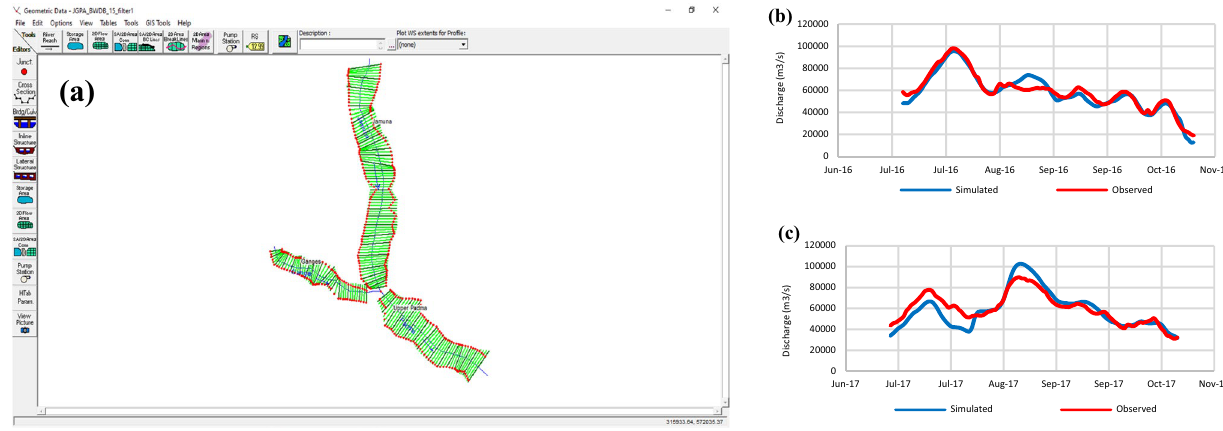
Fig. 4 HEC-RAS 1D a Model set up b Calibration and c Validation of Ganges–Brahmaputra–Padma River system at Mawa (SW